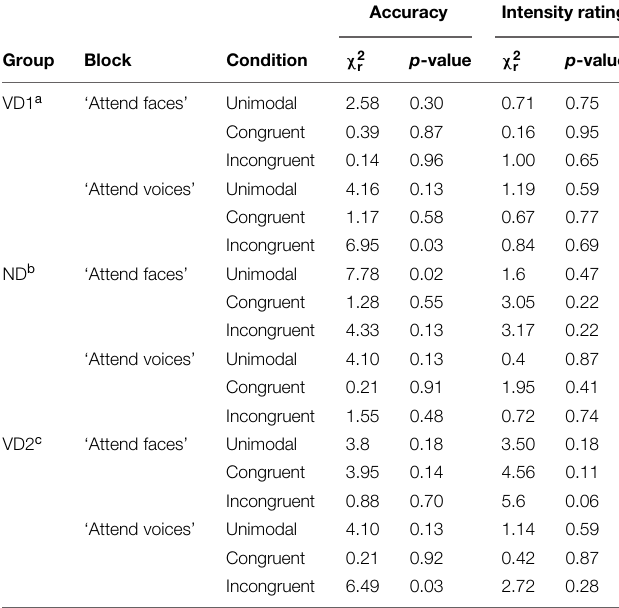
TABLE 2 | Overview of the significant and the non-significant results of the permutation based Friedman rank sum tests computed on the accuracy and intensity rating data from the emotion discrimination experiment, separately for each group, block, and